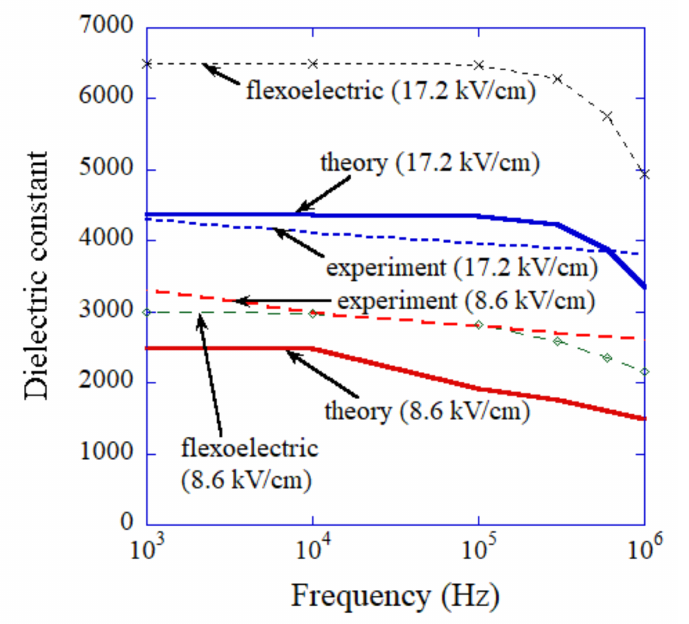
Figure 4. Dielectric constant as a function of frequency. The numerical results on dielectric con- stant solely by flexoelectric polarization are also shown. The experimental data are also shown for